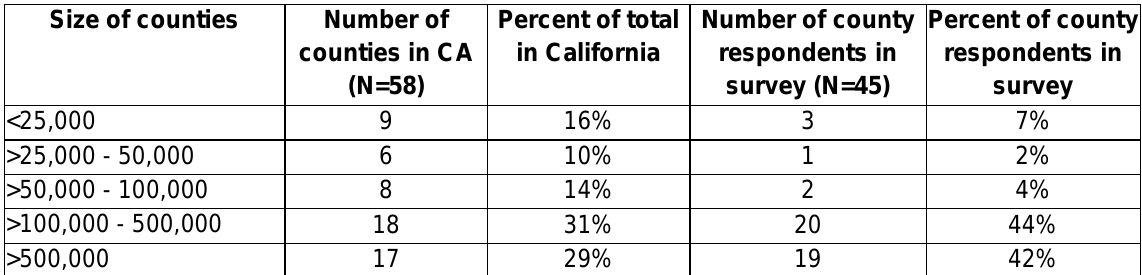
Table A1.2: Distribution of California counties by size (based on US Census 2012) and of respondents’ locations (based on reported affiliated county size)